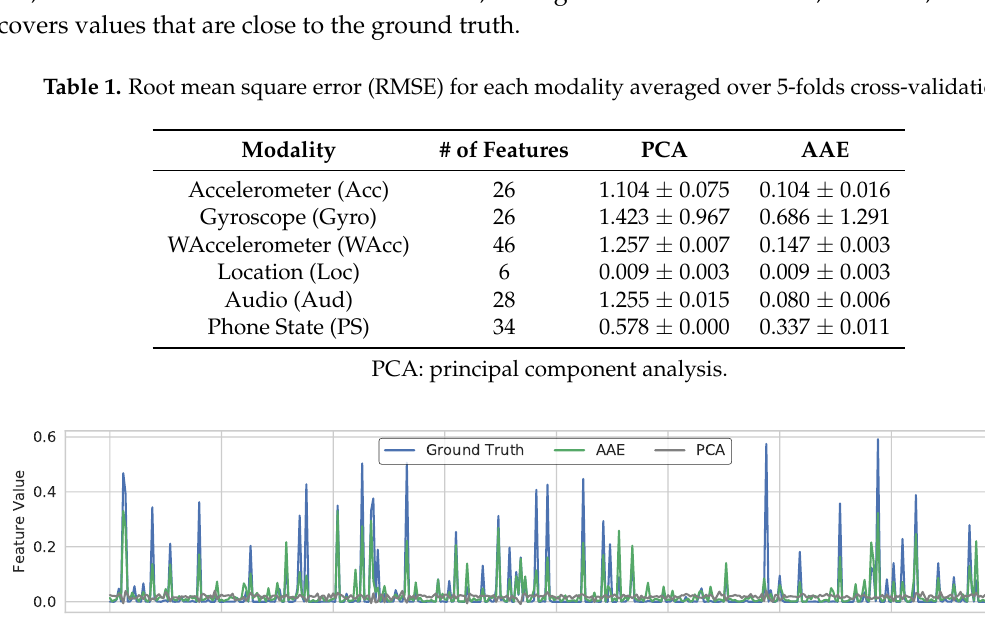
Figure 6. Restoration of an (phone) accelerometer feature values with the AAE and PCA. The entire modality is dropped and reconstructed using features from the remaining signals.